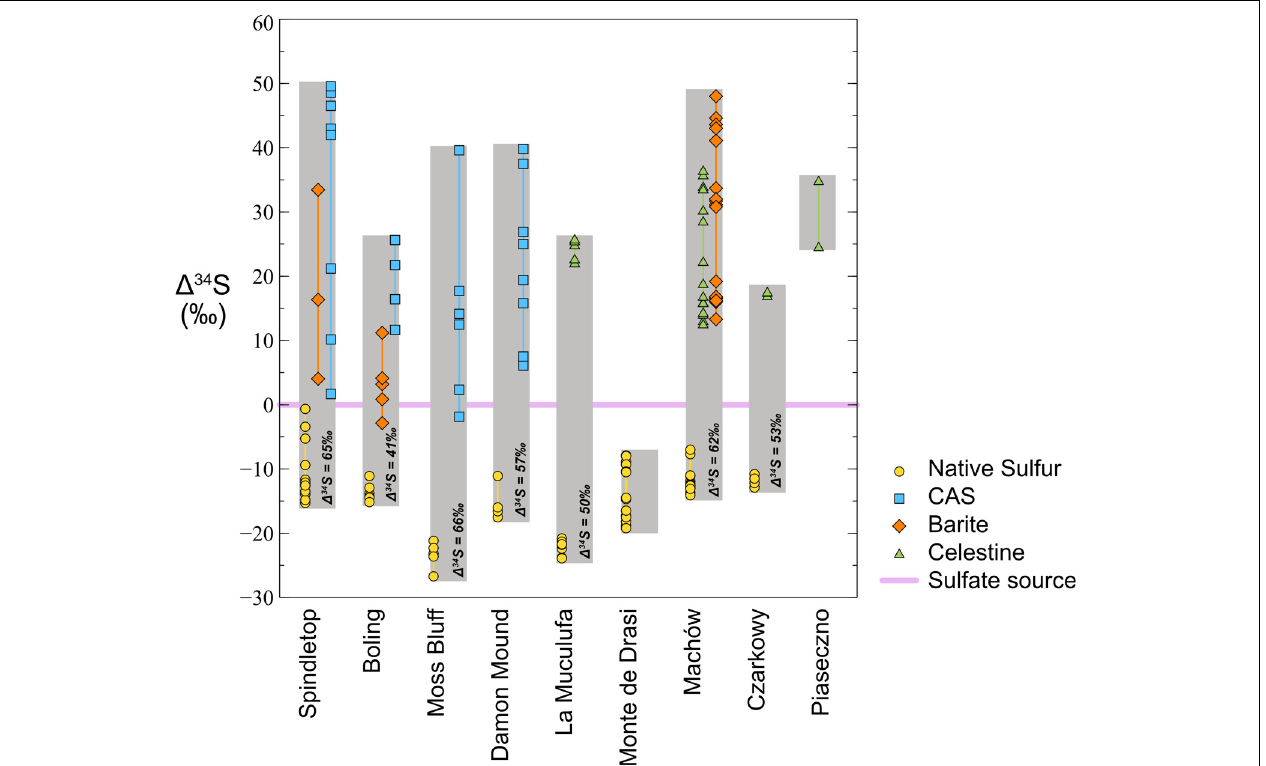
FIGURE 5 | Sulfur isotopes systematics in epigenetic sulfur deposits. Compilation of data from United States Gulf Coast, Polish, and Sicilian native sulfur deposits, data normalized to presumed sulfur isotope composition of sulfate source (set to zero, data presented as an offset between isotope compositions; (cid:49) 34 S). The sulfur isotope compositon of native sulfur is lighter and the residual sulfates isotopically heavier than the original sulfate mineral. The isotope offset between native sulfur and original sulfate is much smaller than the offset between original sulfate and residual sulfate. However, the enrichment in 34 S does not exceed the theoretical maximum isotope fractionation for microbial sulfate reduction. Data sources: Huckley, Boling, Moss Bluff, and Spindletop domes (Feely and Kulp, 1957; Kyle and Agee, 1988); Damon Mound (new data); Poland (Parafiniuk et al., 1994); Sicily (Ziegenbalg et al.,